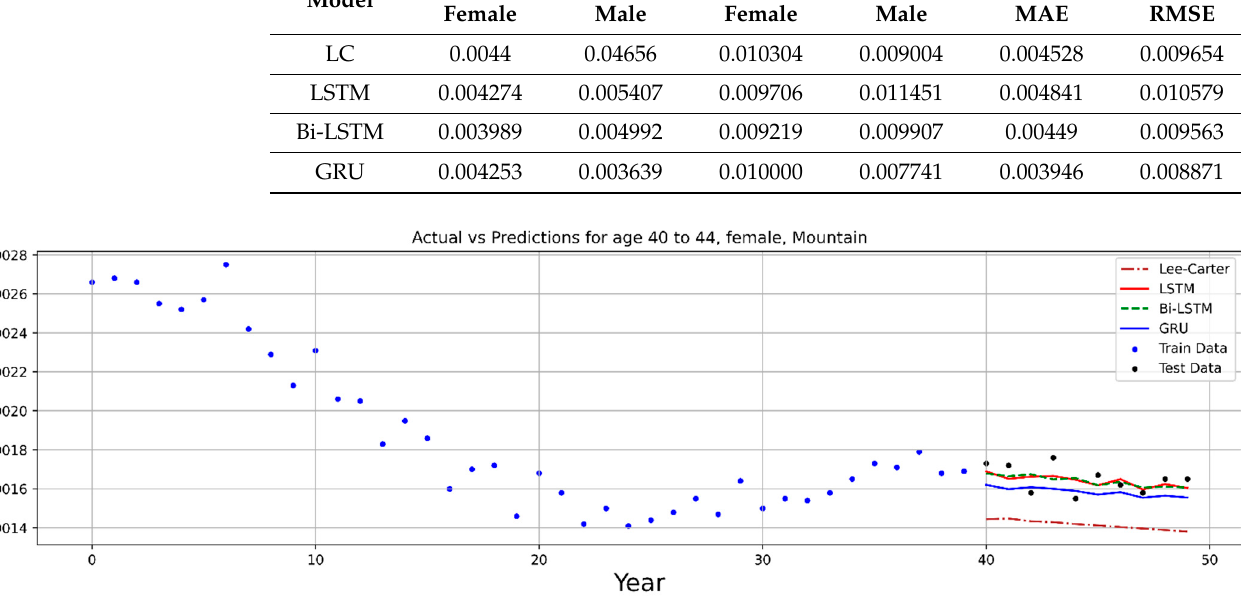
Figure 4. The life expectancy of models in the age group 40–44, Mountain female population.